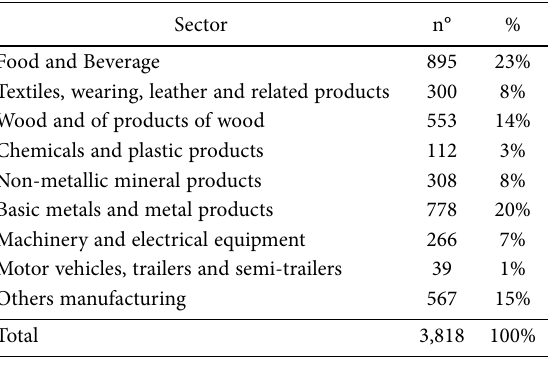
Table 1. Number and % of Basili- cata’s operating firms by econom-